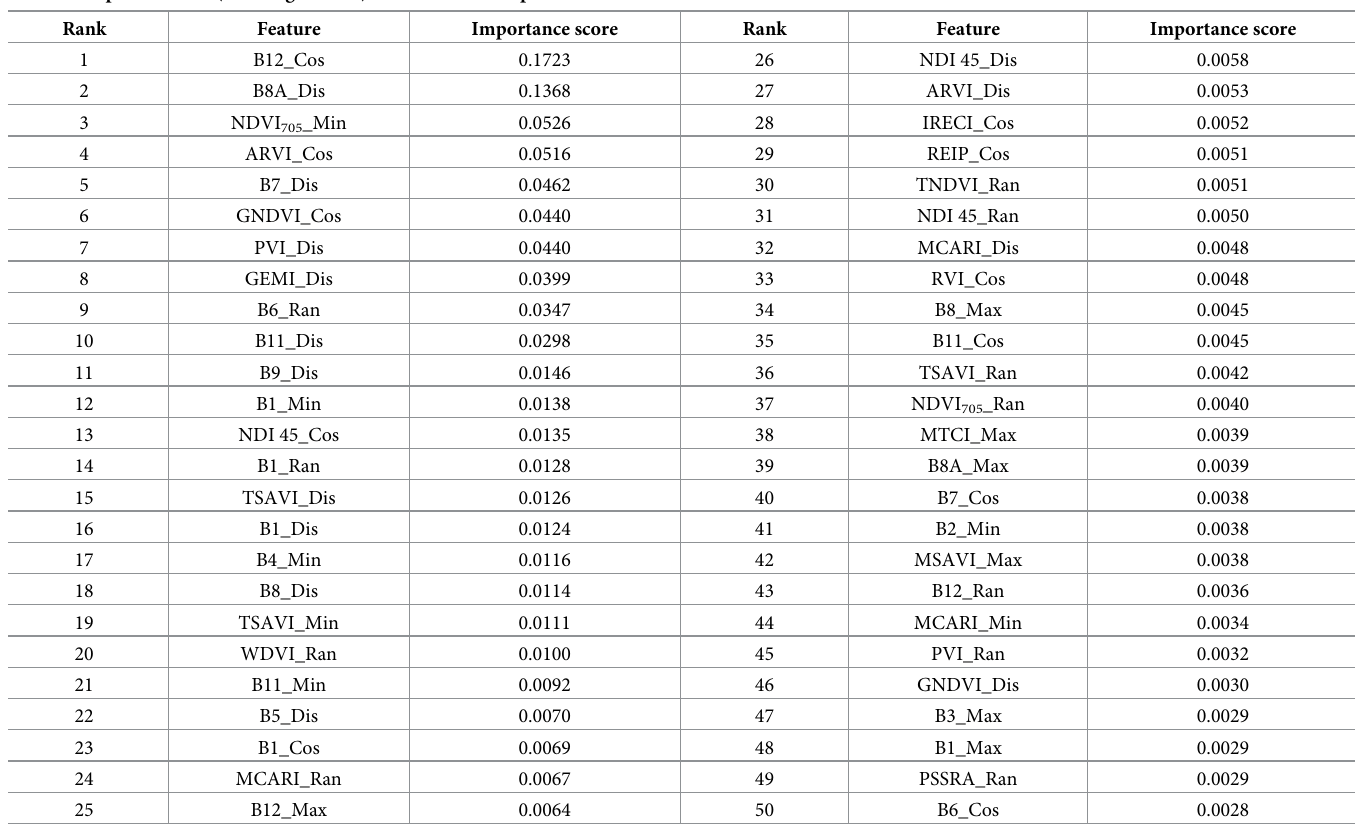
Table 5. Top 50 features (from high to low) in terms of the importance